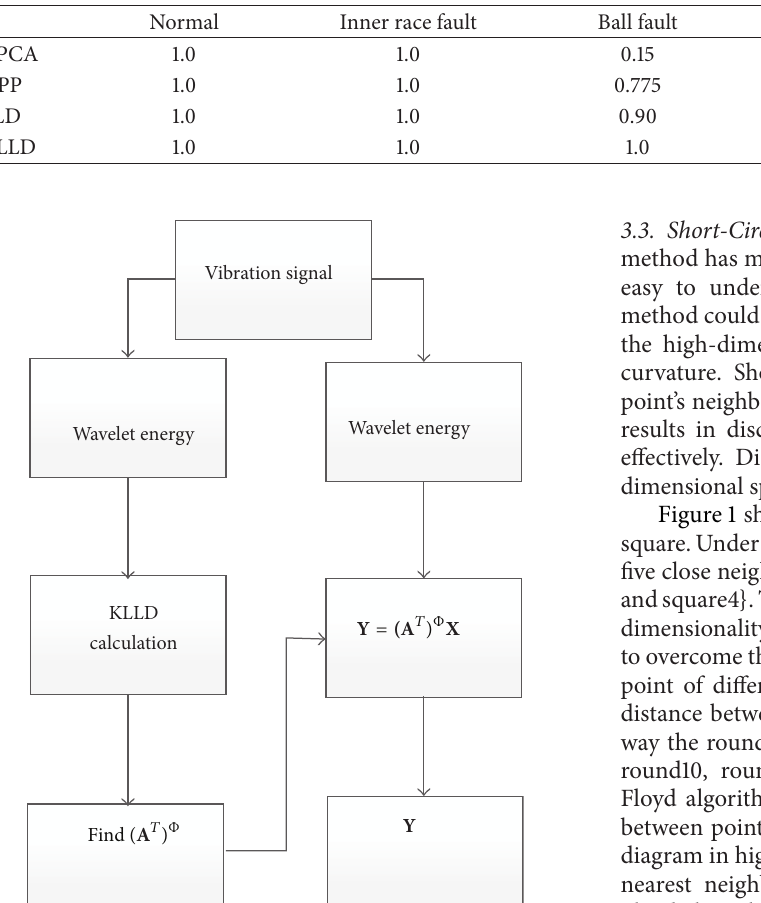
Table 6: Comparison of four dimensionality reduction methods for classification.